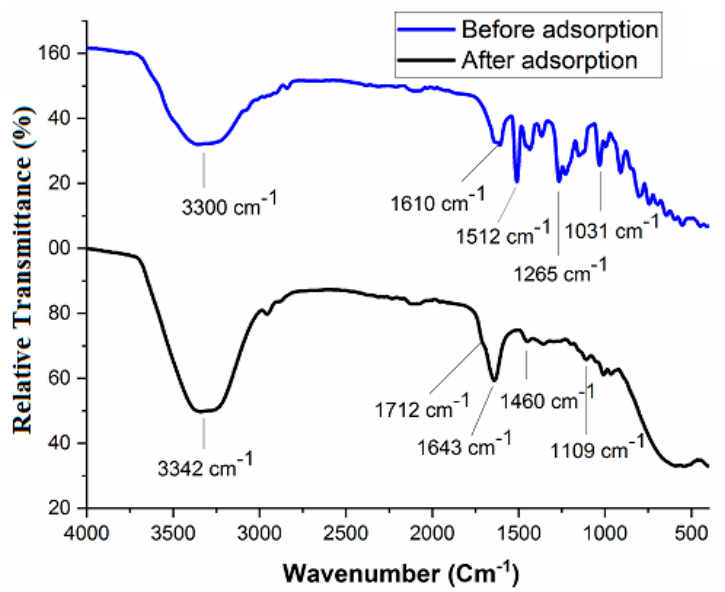
Figure 2. ATR − FTIR of CNP/EDTAPEI sorbent before and after metal ion adsorption.